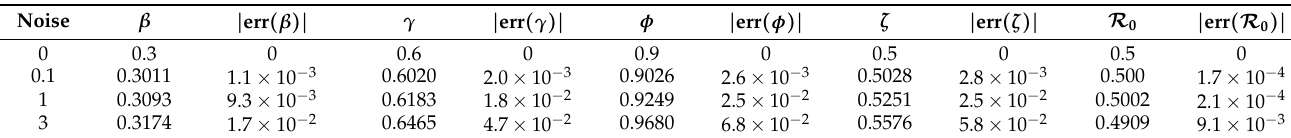
Table 3. Performances of the proposed physics-informed framework in the data-driven discovery of the SEIRS model with different noise on the data, with n = 100 and L = 80, µ = 0.5 (the training time is on the order of milliseconds).